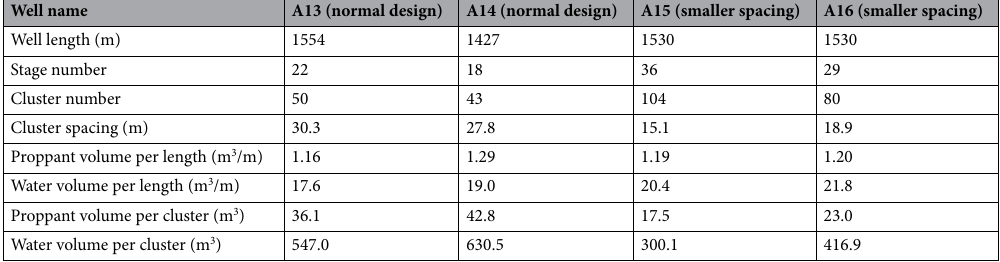
Table 3. Information of comparison wells with different fracture spacings.